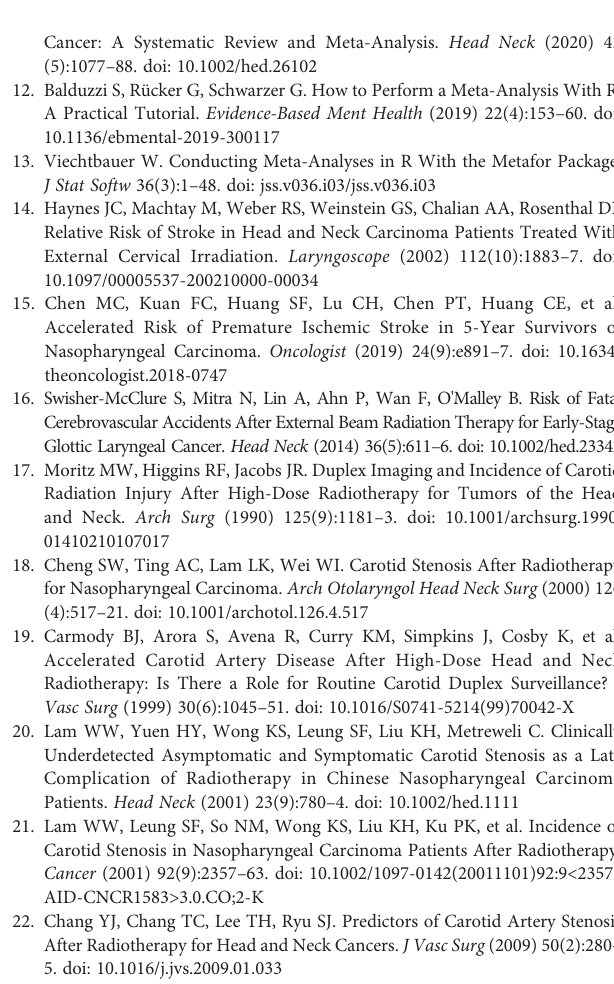
Supplementary Figure 1 | The prevalence of CVD risk (CA stenosis>50% as increasing risk for CVD) for patients after radiotherapy to the neck was 33% (95% CI: 29%-38%) among studies published before 2004. Supplementary Figure 2 | The prevalence of CVD risk (CA stenosis>50% as increasing risk for CVD) for patients after radiotherapy to the neck was 19% (95% CI: 16%-22%) among studies published after